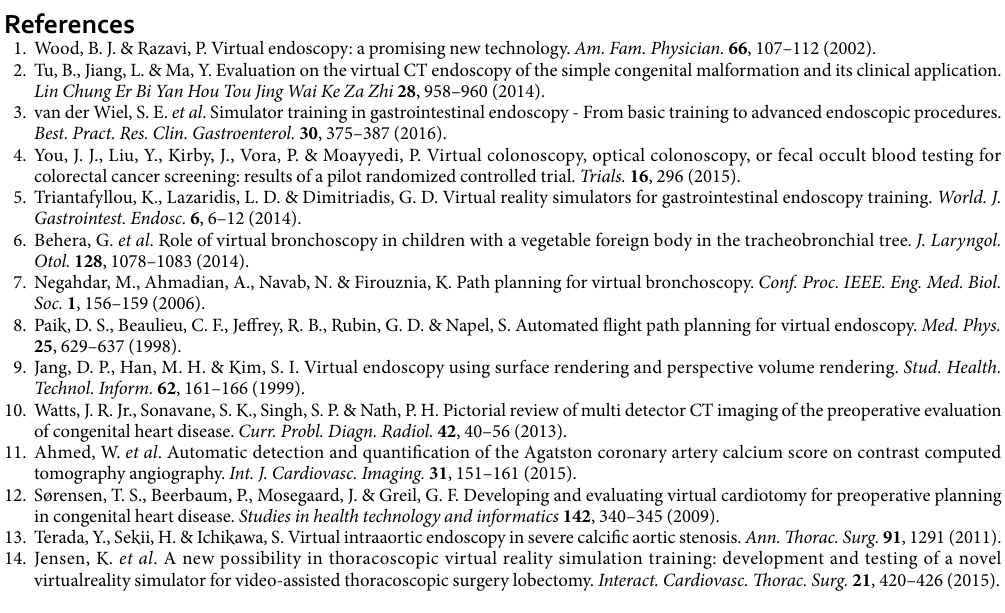
Our results demonstrate the considerable value of the VE system in the diagnosis of CHDs. For the roaming pathway generation in the diagnosis of CHDs, the left heart system (including the left atrium, left ventricle and aortic artery) or right heart system (including the right atrium, right ventricle and the main pulmonary artery) could be modeled as one cavity object, while the rest should be treated as separate objects.